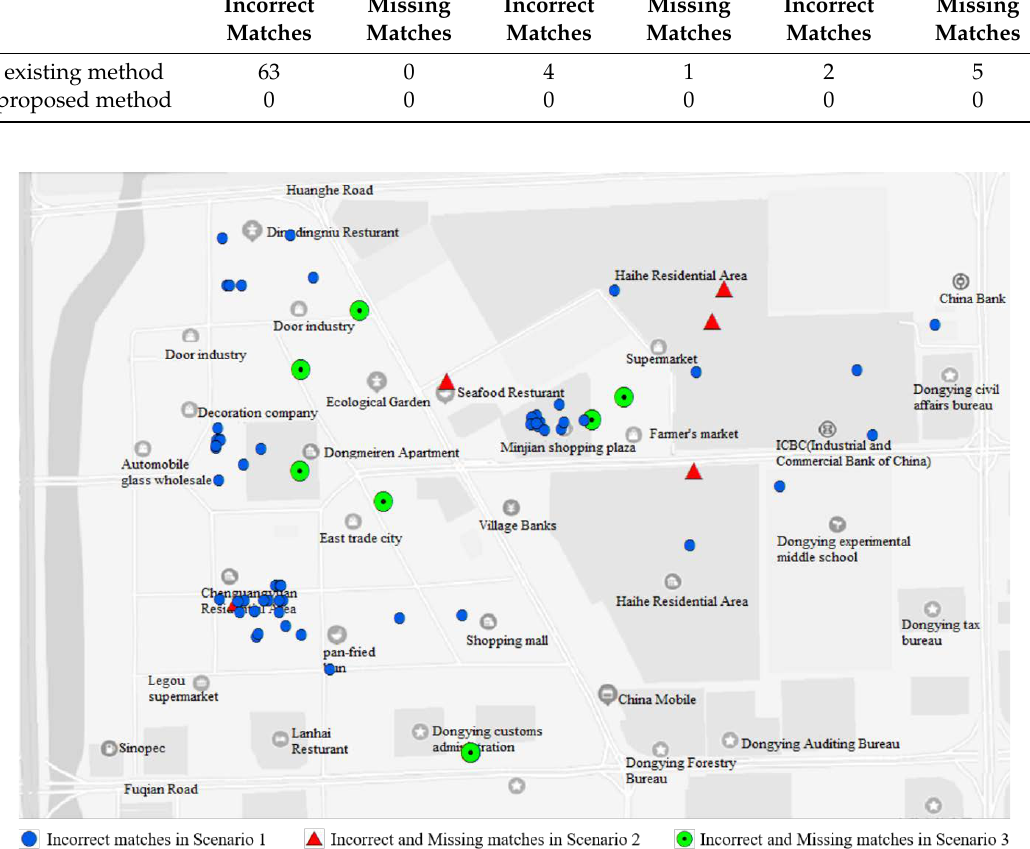
Figure 13. Spatial distribution of the POIs in the three scenarios.